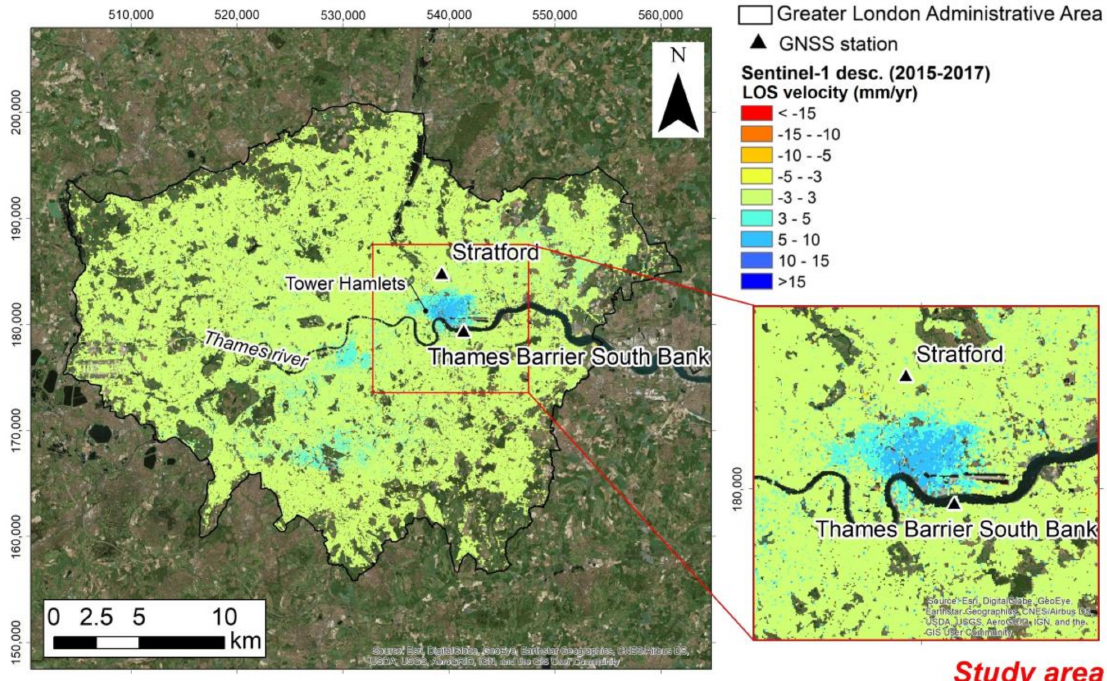
Figure 2. Average line of sight (LOS) velocity measured by the use of Sentinel-1 data during the period 2015 to 2017 across the study area. The location of the GNSS station is also